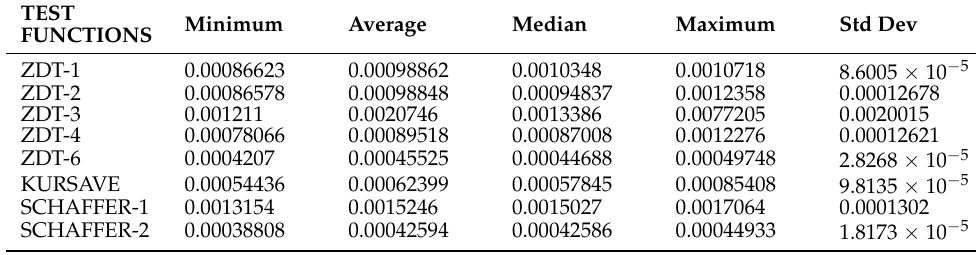
Table 4. Results of IGD METRICS on test